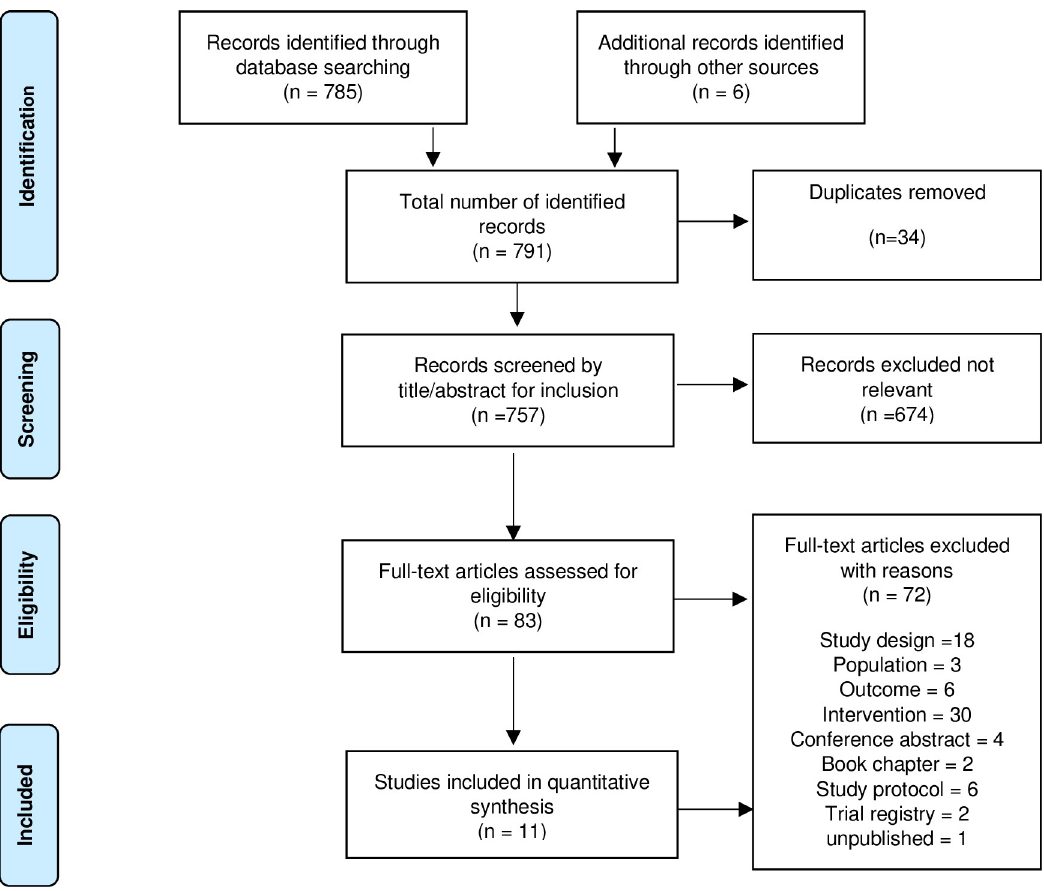
Fig 1. PRISMA flow diagram of included